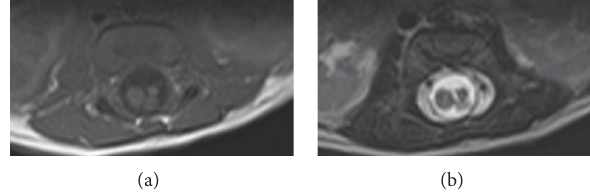
Figure 4: Axial T1 (a) and T2 (b) of lower lumbar region demon- strating the triplet splitting of the cord noted that the left cord is the one resplitted.